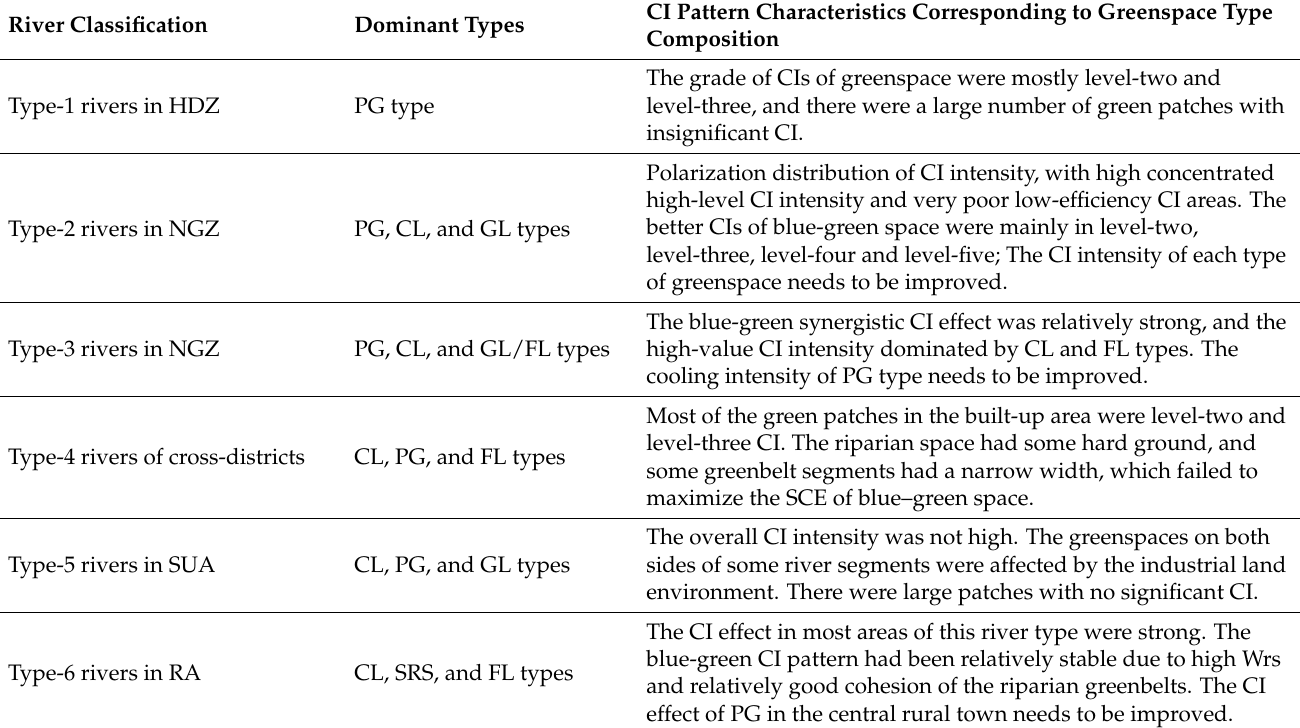
Table 12. CI spatial characteristics of riverfront greenspace at six river-type